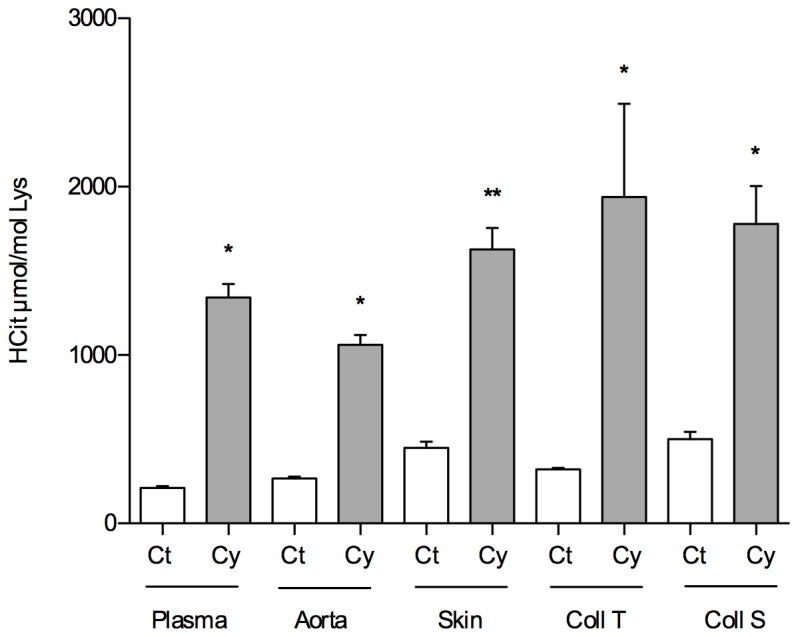
Carbamylation of tissue proteins in the isocyanic acid-consumption model.The carbamylated protein content of the aorta and skin, and purified collagen from the tail (Coll T) and from the skin (Coll S) are shown for mice that received 3 weeks of drinking water containing 0.5 mM sodium cyanate (Cy, grey bars) or normal drinking water (Ct, white bars). Each bar represents the mean value of the 5 mice in the group. CP concentration is expressed as the ratio of homocitrulline (μmol) to lysine (mol). Mann-Whitney U test: *: p<0.05, ** : p<0.01.